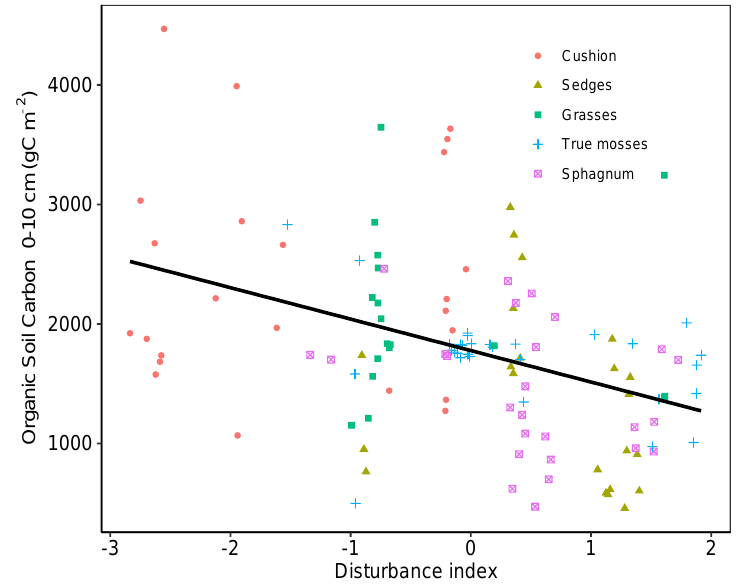
Figure 7. Relationship between carbon content on the 0 – 10 cm interval and a scaled disturbance observed at each of 121 peatlands in the northern Andes. Higher values of the disturbance index indicate higher evidence of human disturbance in the peatland.